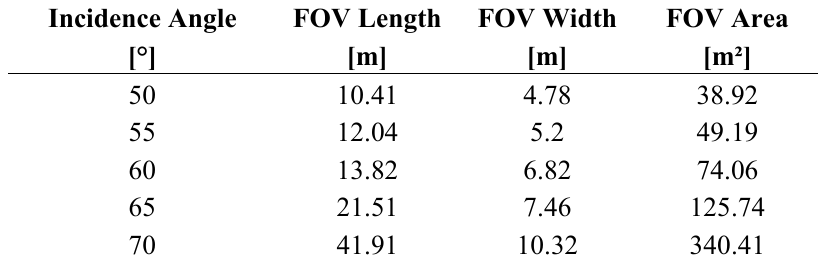
Table 2. Footprint dimensions of the elliptic 3 dB footprint at incidence angle θ .